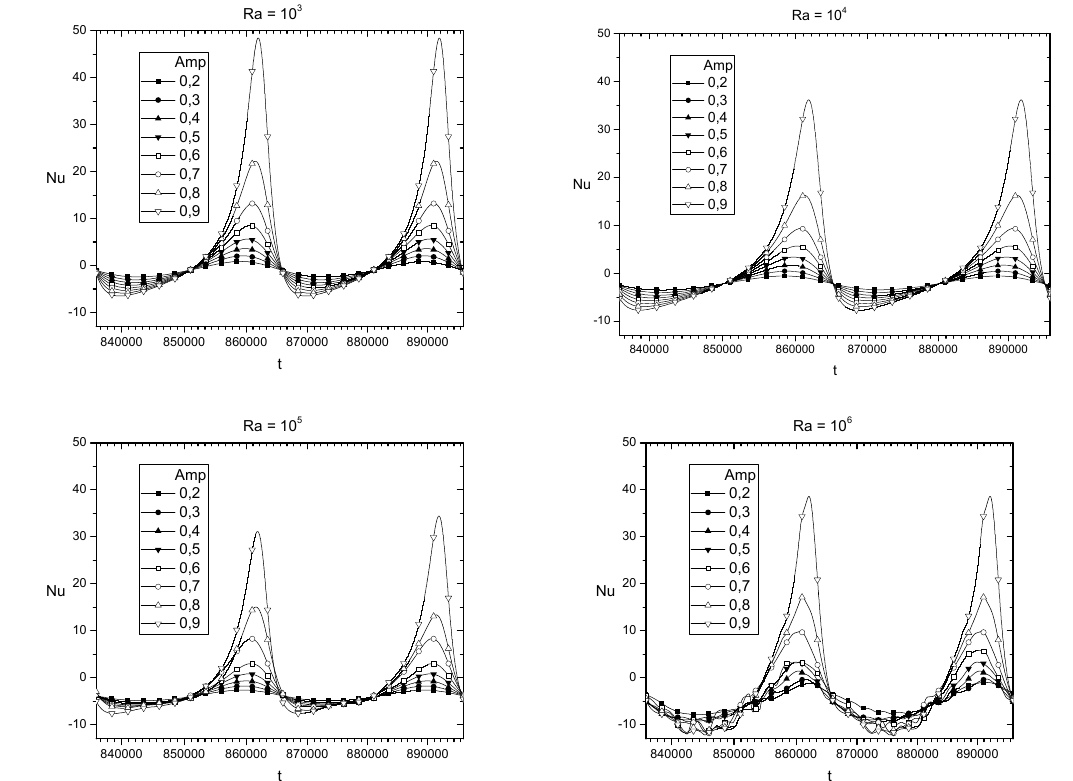
Figure 9. Evolution of the Nusselt number “Nu c ” (at the top wall) as a function of time for different Amp over the last two periods.